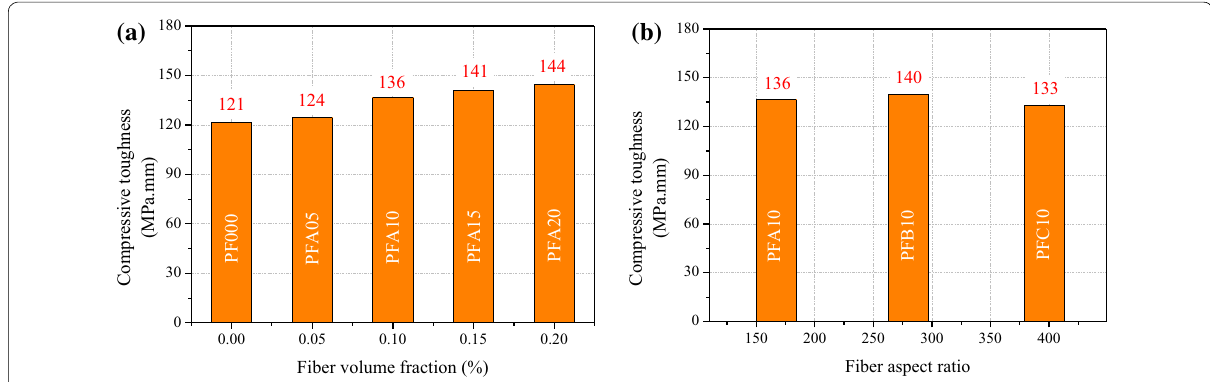
Fig. 5 The compressive toughness of concrete. a Effect of fiber volume fraction. b Effect of fiber aspect